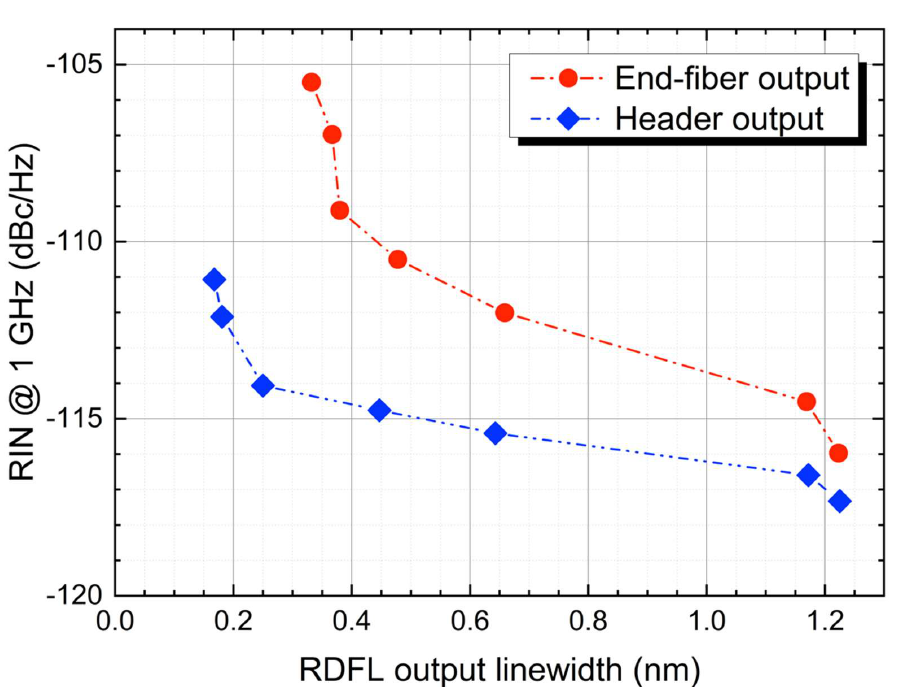
Figure 5. Evolution of the 50 Km RDFL RIN at 1 GHz, for the header (blue) and end-fiber (red) outputs.